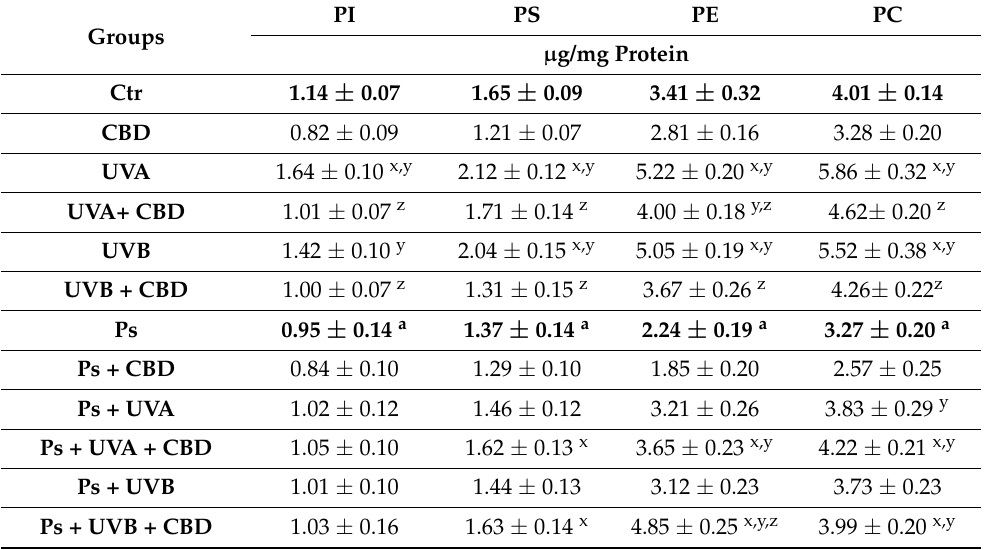
Table 1. Phospholipids membrane composition of keratinocytes isolated from skin of healthy subjects (Ctr) ( n = 6) and psoriatic patients (Ps) ( n = 6) exposed to ultraviolet A (UVA) (30 J/cm 2 ) and ultraviolet B (UVB) (60 mJ/cm 2 ) radiation as well as untreated and treated with cannabidiol (CBD) (4 µ M). The mean values ± SD and statistically significant differences for p < 0.05 are presented.